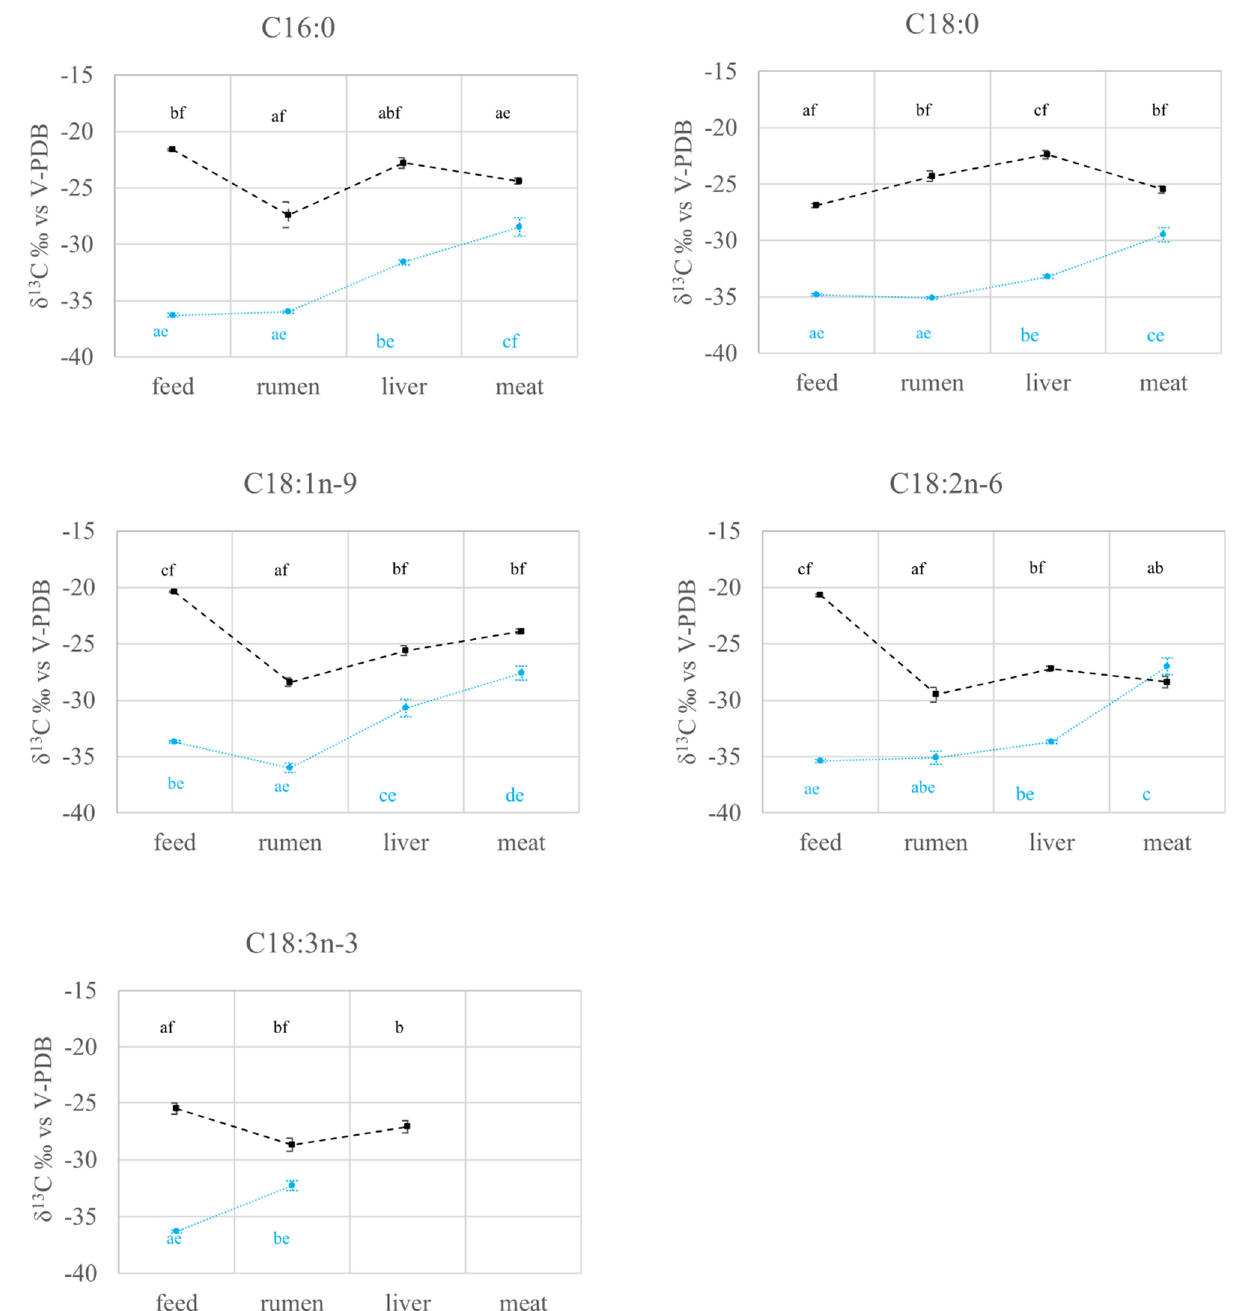
Figure 3. Variations (mean ± se) of δ 13 C (‰) of FAs in different compartments (feed, rumen, liver, meat) of cull cows fed with diets based on C3 (C3 group, blue) and C4 (C4 group, black) plants. a, b, c: p < 0.05 within experimental group; e, f: p < 0.05 within compartment. c: p < 0.05 within experimental group; e, f: p < 0.05 within